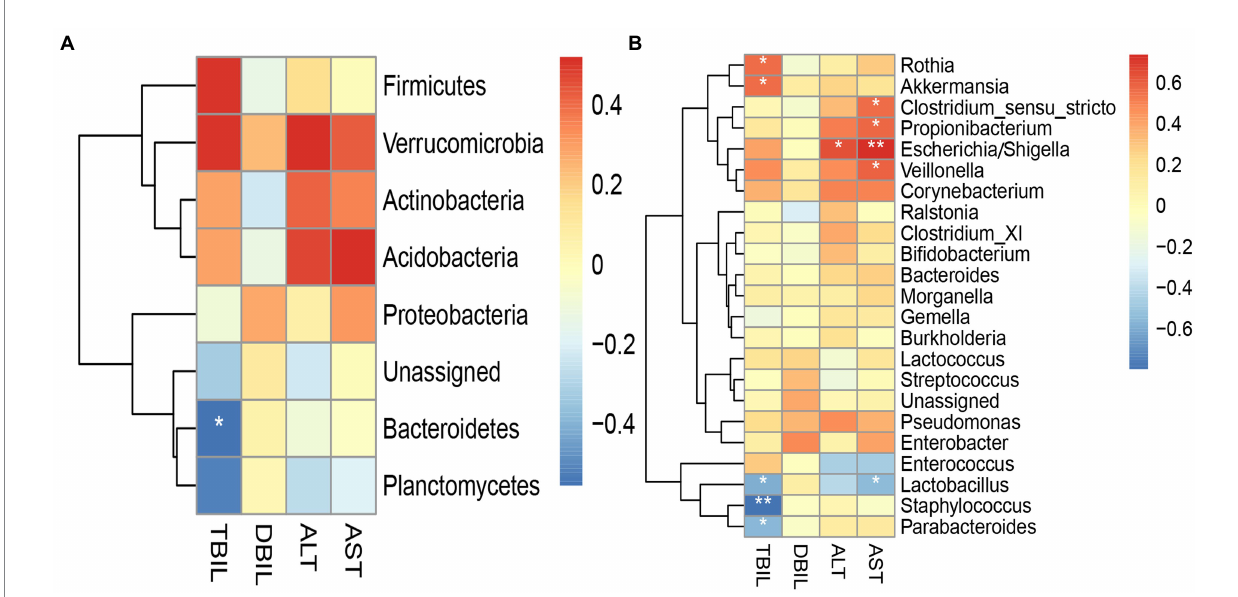
FIGURE 8 Heatmap for Spearman’s rank-sum correlation coefficient between gut microbiota and clinical indices in the case group. The red color on the heatmap indicates a positive correlation, while blue indicates a negative correlation. The darker the color, the larger the correlation coefficient. *value of p ≤ 0.05, **value of p ≤ 0.01. (A) Correlation between gut microbiota at the phylum level and clinical indices. (B) Correlation between gut microbiota at the genus level and clinical